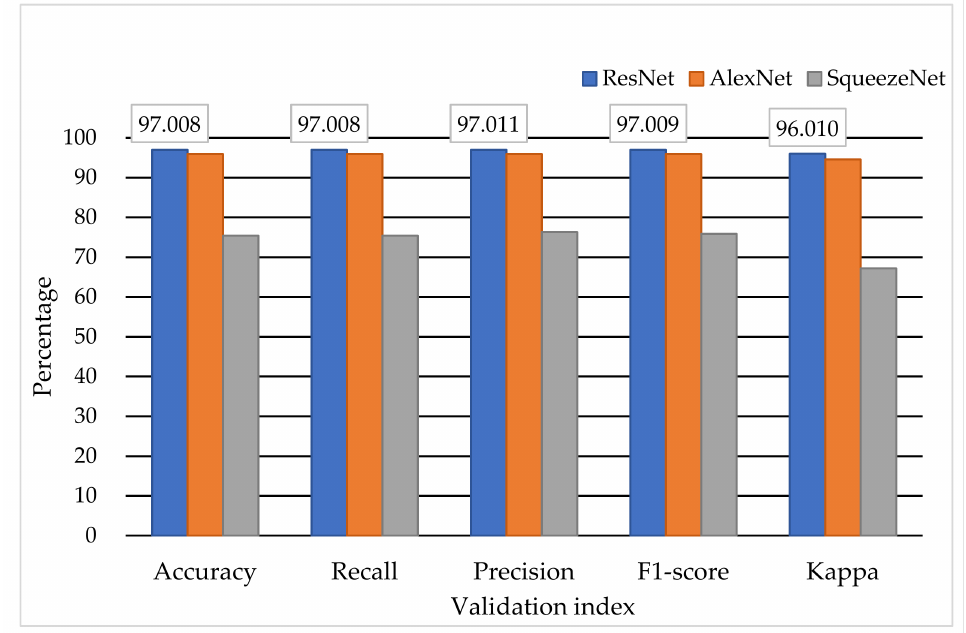
Figure 5. The classification results by different DNN